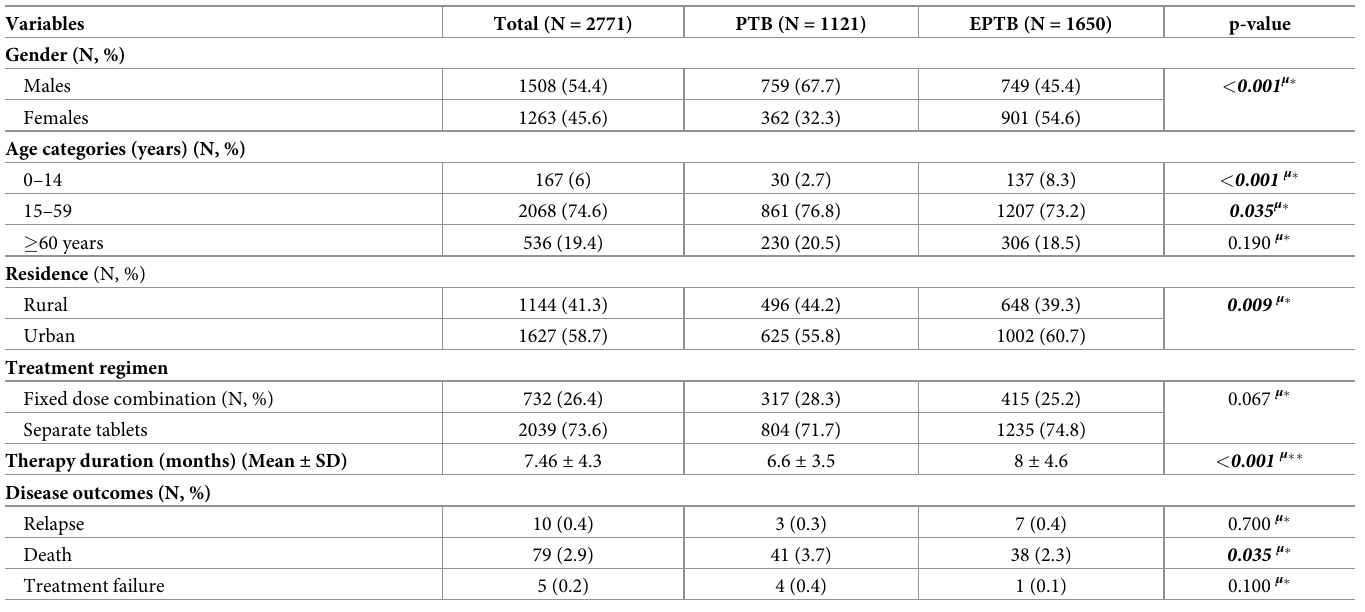
Table 1. Comparison of basic demographic and clinical characteristics between pulmonary and extra-pulmonary tuberculosis